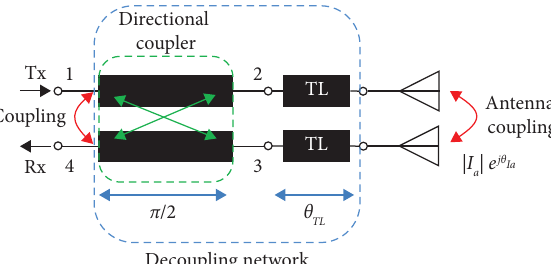
Figure 3: Schematic of Tx/Rx antennas with proposed decoupling network using single directional coupler and transmission lines.